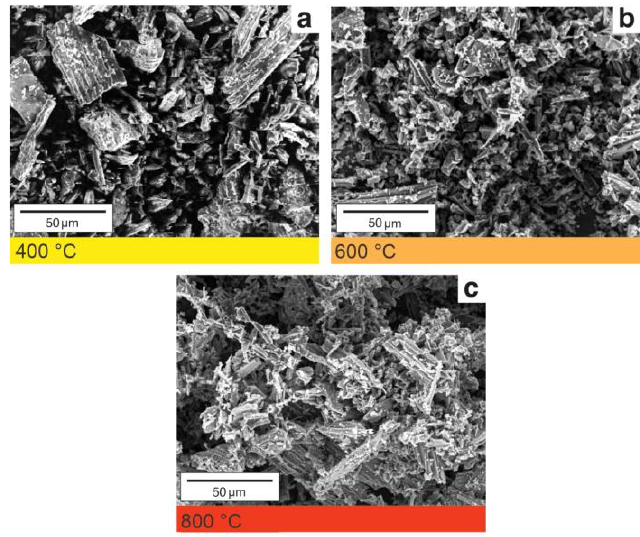
Figure 4. Micrographs obtained by scanning electron microscopy of charcoal fine samples synthesized at 400 ( a ), 600 ( b ), and 800 °C ( c ) in ×300 magnification.